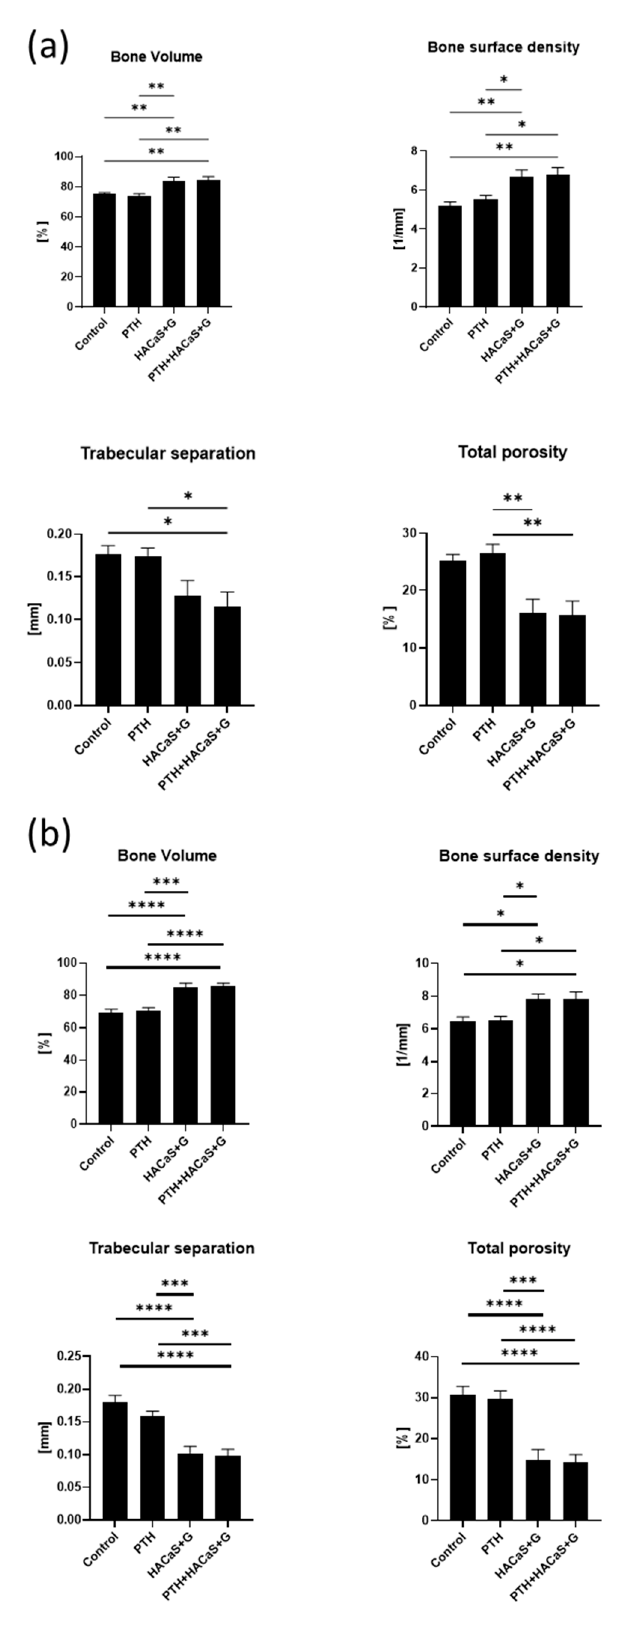
Figure 2. 3D Analysis of bone tissue: ( a ) 4 weeks after the second surgery and ( b ) 8 weeks after the second surgery. * = p < 0.05, ** = p < 0.01, *** = p < 0.001, **** = p < 0.0001, ns = not significant.